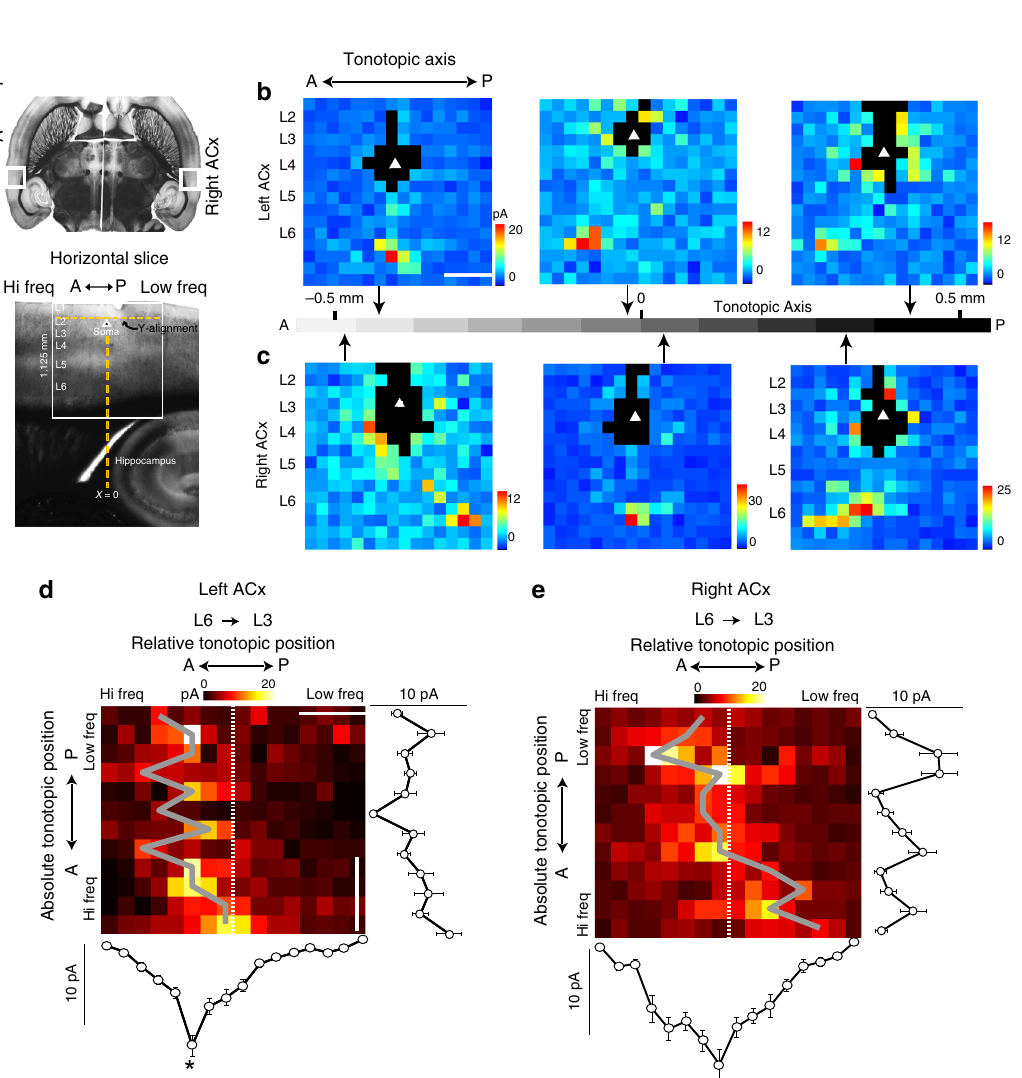
Fig. 3 Tonotopic connectivity differs between the left and right ACx. a Horizontal slices capture the anterior – posterior (A ↔ P) representation of tonotopy in the left and right ACx (top); white box scale 1 mm × 1 mm. DIC image of a horizontal slice during an experiment depicting the anatomical landmarks used to align consistently the stimulation grid (bottom). b , c Left, middle, and right panels are representative single-cell maps of six L3 neurons mapped at anterior, middle, and posterior locations of the left and right ACx, respectively. Each cell is shown with its native position along the tonotopic axis (arrows); scale bar 0.3 mm. d , e 2D population maps where each row is the average L6 input to L3 cells mapped within 50 μ m from one another and ordered by tonotopic position in the left ACx ( n = 38) and the right ACx ( n = 40), respectively. The x axis is the position of the cells in the LSPS map grid (cells are always centered on their input maps). The tonotopic position of each row is the average distance of the cells binned to the tip of the hippocampus. Dashed white line represents the soma position and gray lines connect pixels of maximum input strength. Line plots in d and e are the columnar and row averages of synaptic input calculated from the 2D population maps. Asterisk indicates that synaptic input arising from the anterior and posterior areas of the 2D population map were signi fi cantly different ( p = 1.4e-3, n = 38, Wilcoxon rank-sum). X scale bar 0.3 mm, y scale bar 0.33 mm. All data are presented as mean ± input became columnar at more anterior portions of the left ACx pathway arose from L6 neurons located several hundred microns where the highest frequencies are represented (Fig. 3b left). anterior to the L3 postsynaptic neuron (henceforth, out-of-col- Mapping the corresponding anatomical area in the right ACx umn) throughout most of the ACx, and consistently from puta- revealed strikingly different connectivity from that found in the tive higher frequency bands (Fig. 3b middle and right). The L6